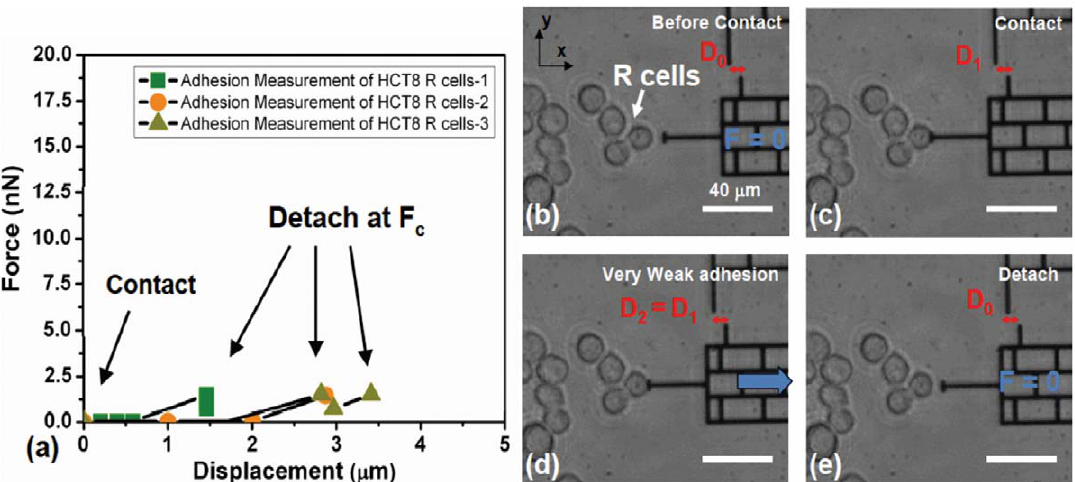
Figure 6. Surface non-specific adhesion of R cells measured by micro-fabricated bio-MEMS force sensor. (a) Adhesive force of R cells on MEMS probe as the probe is moved away from the cells after 2 min contact (n=25). (b–e). Phase-contrast images of R cells and MEMS probe when non-specific adhesion between them is measured. The maximum detachment force measured is , 2.5 nN, while the cell deformation is barely noticeable. Scale bar: 40 m m.